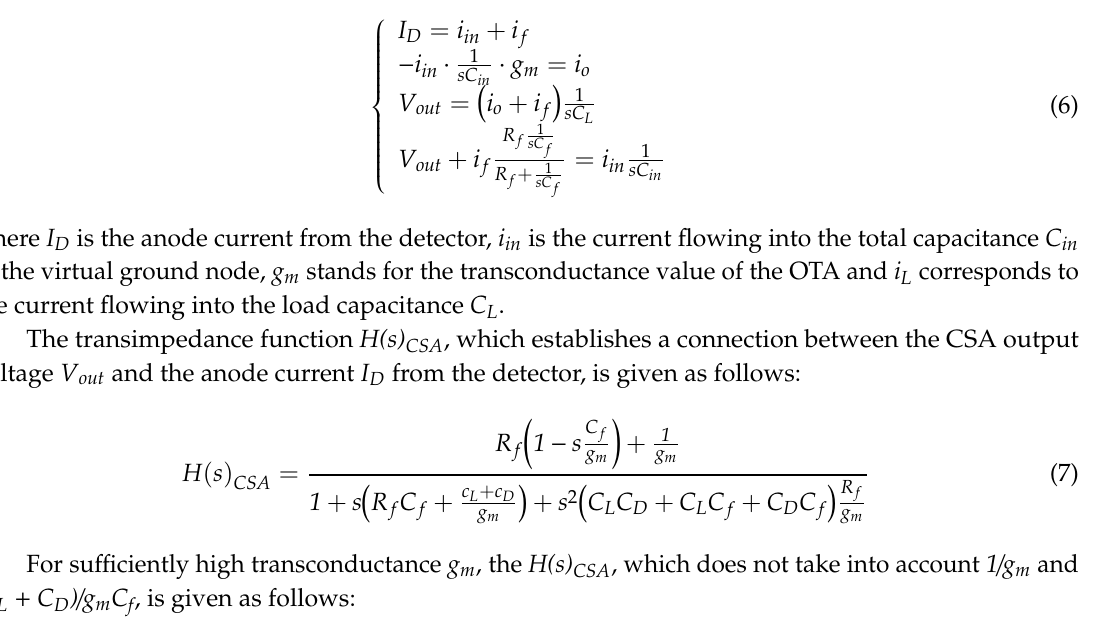
Figure 7. Current flow diagram of the CSA. The current I D from the MCP detector flows to the currents i f and i in . The current i b in the dotted line is typically ignored because of the OTA’s high input impedance characteristics. In the same way, the current i L amounts to the convergence of the currents i f and i o . Node V in and node V out are presented in the form of voltage.